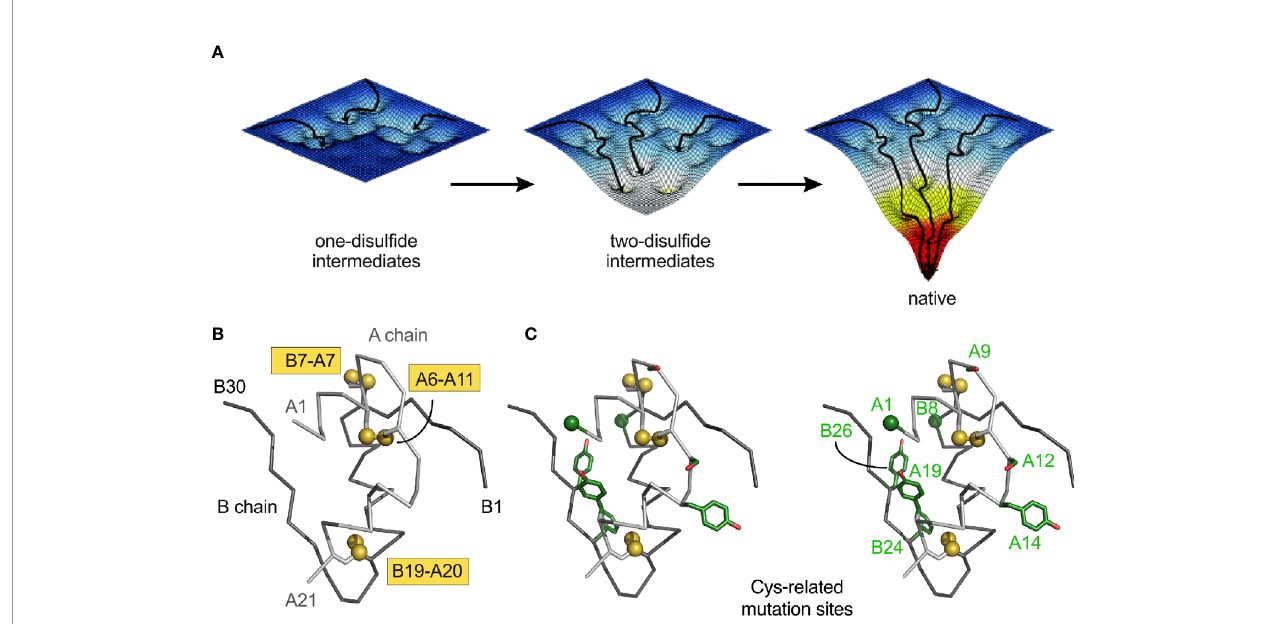
FIGURE 2 | Energy landscape paradigm. (A) Landscape maturation: successive disul fi de pairing enables a sequence of folding trajectories on ever-steeper funnel- shaped free-energy landscapes. (B) Ribbon model of insulin showing the three native disul fi de bonds (yellow boxes). Coordinates were obtained from PDB entry 4INS (47). The A- and B chains are shown in light- and dark gray, respectively. (C) Stereo view of insulin with Cys substitutions highlighted in green ( Table 1B ). Side chains are shown as sticks; Cys-related sulfur atom and alpha-carbons of Gly A1 and Gly B8 represented as spheres (one-third Van der Waals